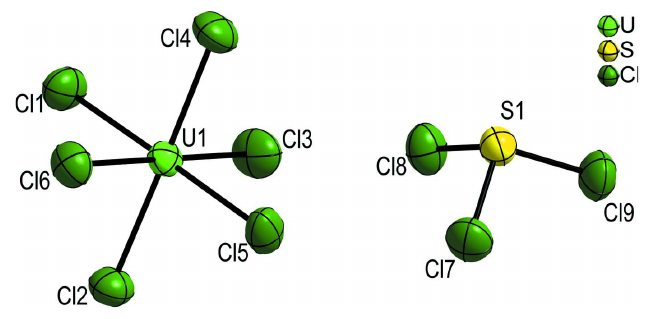
Figure 1 The slightly distorted trigonal–pyramidal [SCl 3 ] + cation and octahedral [UCl 6 ] (cid:2) anion of the title compound. Displacement ellipsoids are shown at the 90% probability level.